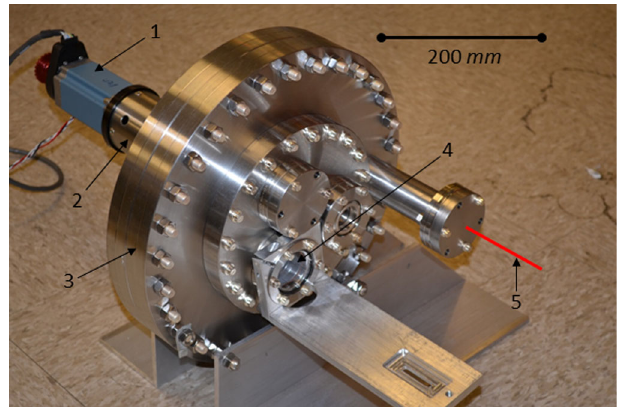
FIG. 2 (color online). A photograph of the wire scanner: (1) stepper motor; (2) ferrofluidic rotary feadthrough; (3) vacuum flanges; (4) vacuum flange with viewports; (5) beam